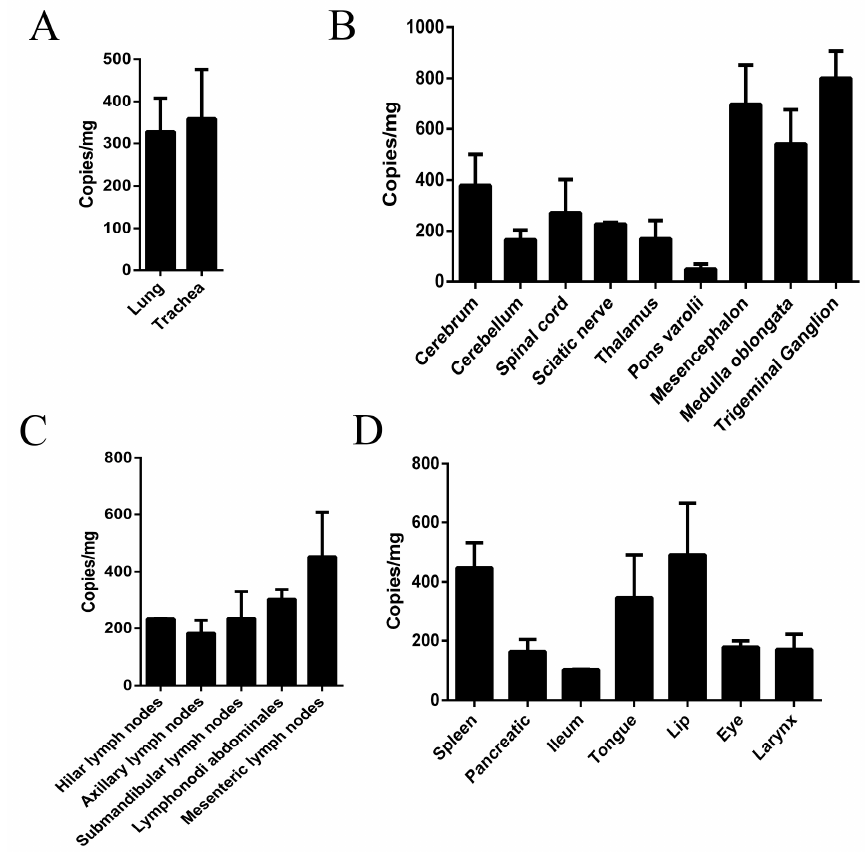
Figure 4. HSV1 distribution in various macaque tissues (No.14065 and No.14137) on day 10 post-infection. HSV1 distribution in tissues include the following: ( A ) respiratory tract, including lung and trachea; ( B ) nervous tissues include cerebrum, cerebellum, spinal cord, sciatic nerve, thalamus, pons varolii, mesencephalon, medulla oblongata and TG; ( C ) lymph nodes include hilar lymph nodes, axillary lymph nodes, submandibular lymph nodes, lymphonodi abdominales and mesenteric lymph nodes; and ( D ) major organs include spleen, pancreatic, ileum, tongue, lip, eye and larynx.